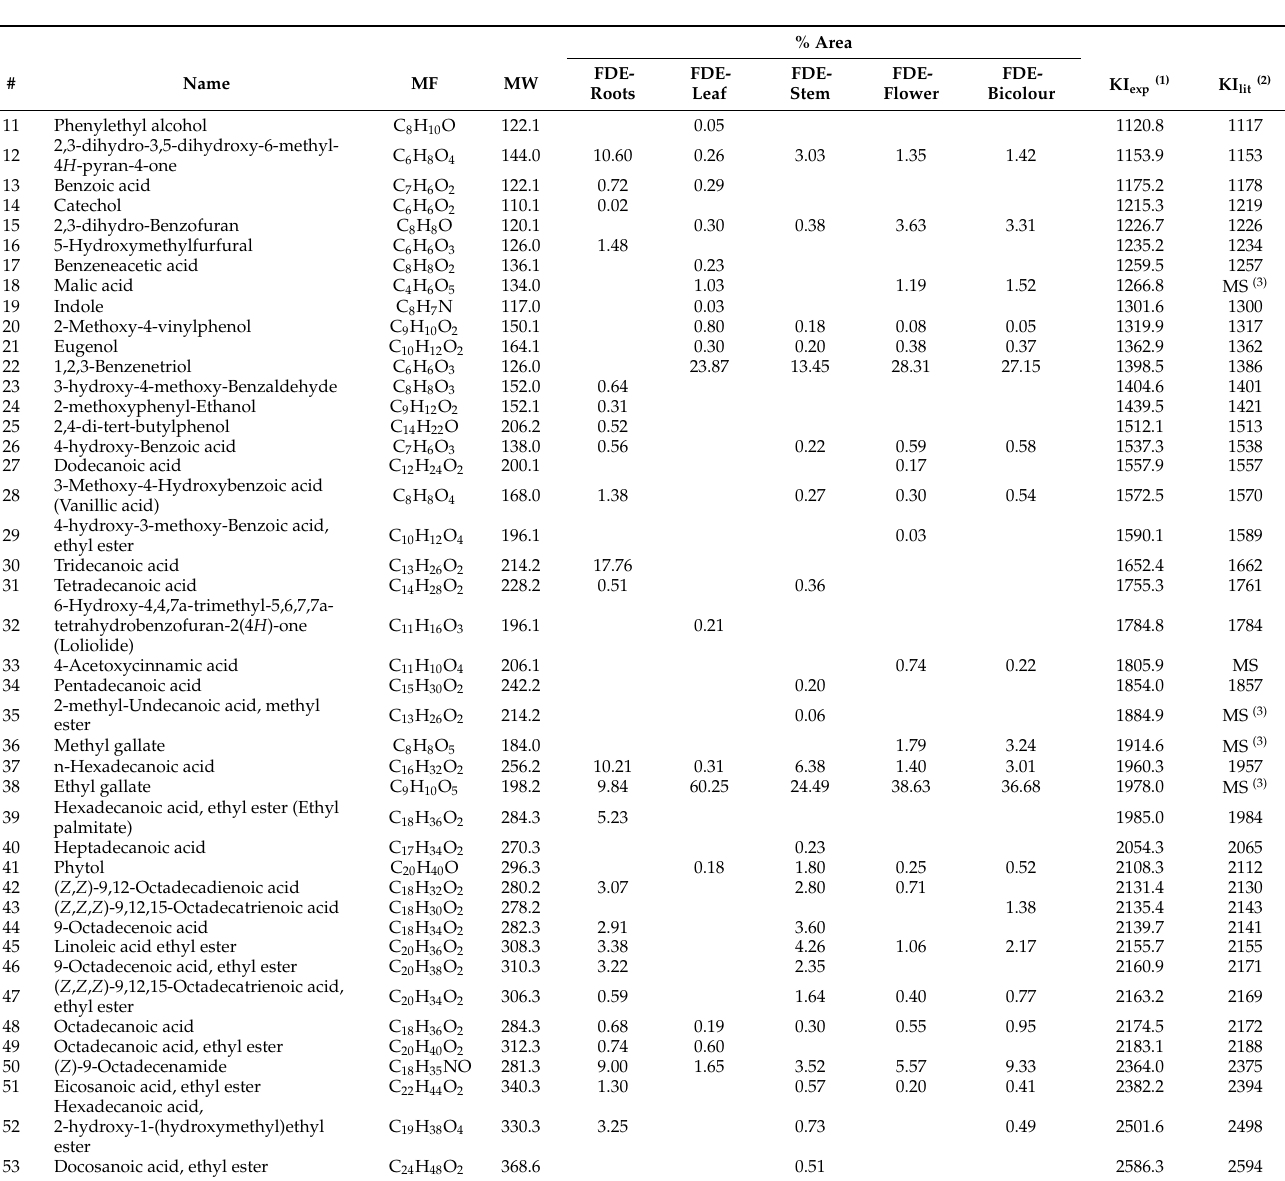
(1) KI exp : Kovats indices calculated from retention time data on a HP-5ms capillary column. from literature (NIST). (3) The Kovats index was not reported on a HP-5ms capillary column, the identification was made by comparison with M.S. mass